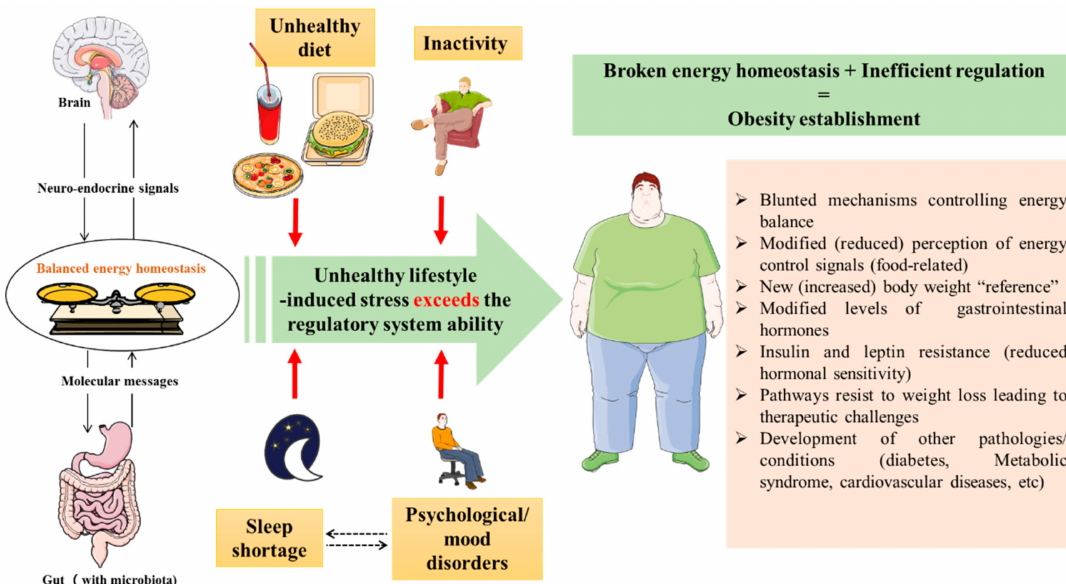
Figure 2. Theory of obesity establishment despite the existence of mechanisms balancing the energy homeostasis. An unhealthy lifestyle (inactivity, unhealthy diet, sleep shortage and psychological disorders) puts pressure on the energy homeostasis balance and breaks it, which leads to obesity development. Once obesity established, the mechanisms of energy balance are blunted, and the brain sets an increased body weight as a new reference, which makes correcting obesity difficult (biological pathways resist weight